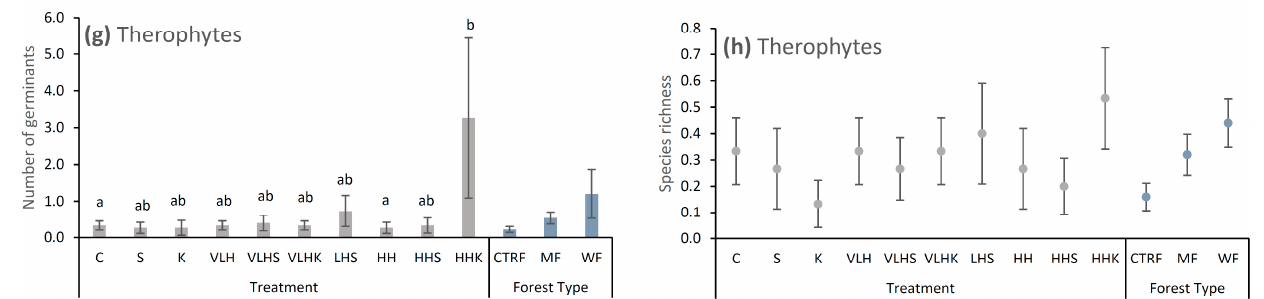
Figure 2. Soil seed bank treatment (see Table 1) and forest type (CTRF, cool temperate rainforest; MF, mixed forest; WF, wet forest) e ff ects on germinant density (bars) and richness (circles) (mean per site, standard error) of: ( a , b ) myrmecochores, ( c , d ) endozoochores, ( e , f ) phanerophytes, and ( g , h ) therophytes. Signi fi cant pairwise comparisons ( p ≤ 0.05) within treatments or forest type are indicated by di ff erent le tt ers. There were no signi fi cant interaction e ff ects. Soil seed bank treatment e ff ects were not signi fi cant for other functional a tt ributes with model results provided in Table S5. There were no signi fi cant di ff erences in functional trait associations among soil seed bank treatments ( Pseudo-F = 1.0, p = 0.3744). Trait associations did however di ff er among forest types ( Pseudo-F = 7.8, p = 0.0001) with no signi fi cant interactions (Table S6). Trait a ffi liation, mobile and obligate resprouters in CTRF relative to MF and WF, and greater abundance of anemochores in WF relative to other forest types (SIMPER, Table S7, Figure S5).